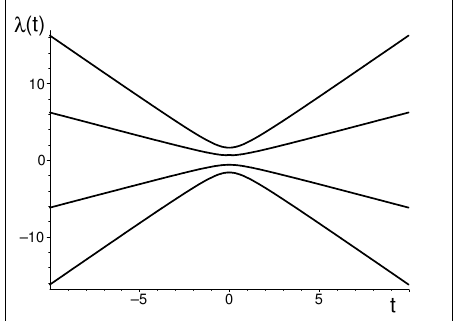
Figure 1. Eigenvalues of matrix (2) (avoided-crossing